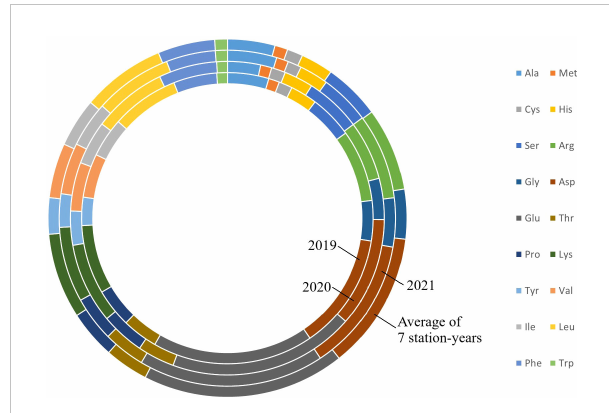
FIGURE 1 Amino acids pro fi le of PR-25 from fi eld trials conducted in Sutherland nursery in 2019, Sutherland, Rosthern, Lucky Lake nurseries in 2020 and Floral, Rosthern and Lucky Lake nurseries in 2021, and the average amino acid pro fi les of PR-25 across the seven station-years.